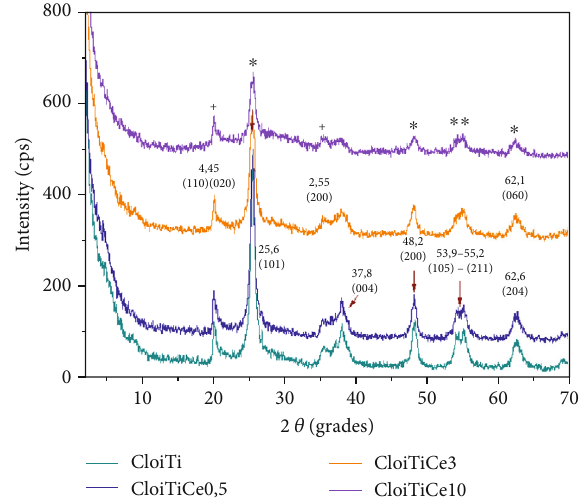
Figure 1: XRD patterns for TiO correspond to Si peaks, whereas the ( ∗ ), to TiO peaks.